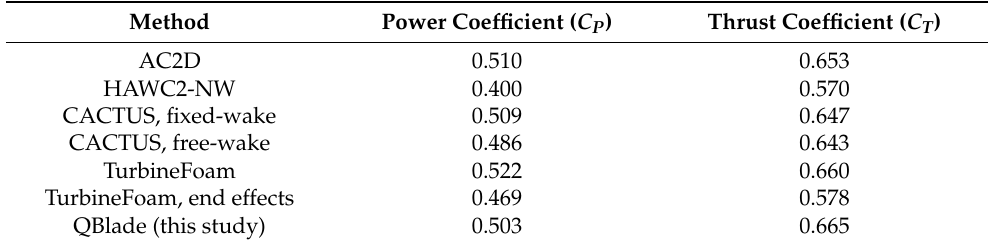
Table 3. Comparisons of Power and Thrust